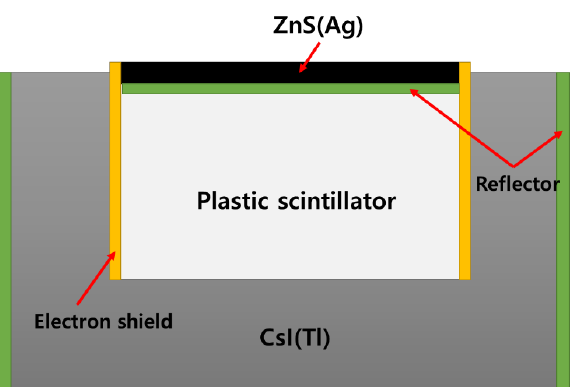
Figure 21. Phoswich detector developed by the National Institute of Radiological Sciences in Ja-